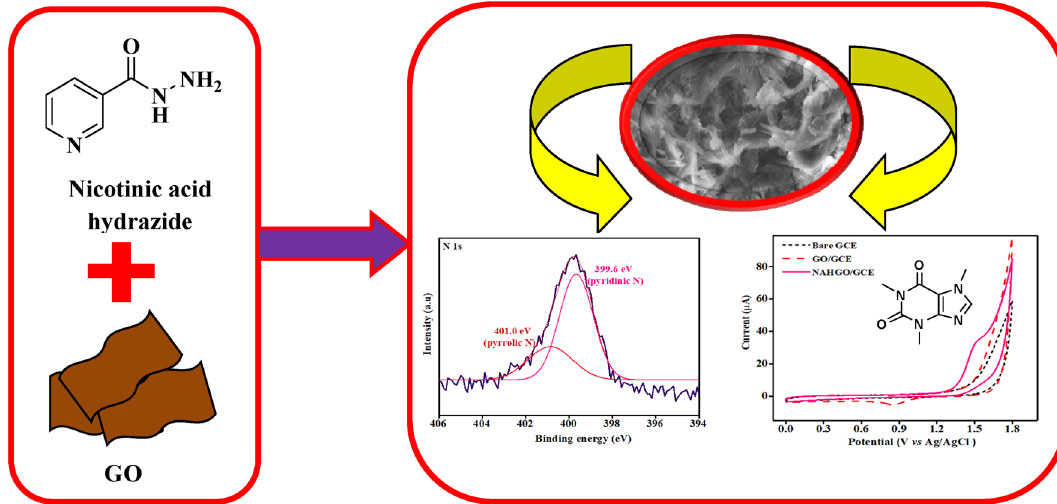
Figure 8. Synthesis and electrochemical activity of NAHGO as a